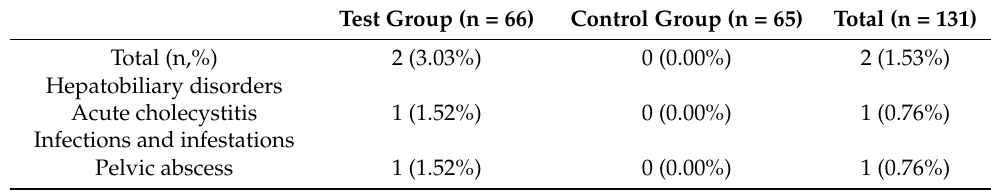
Table 3. Significant adverse effects in the two